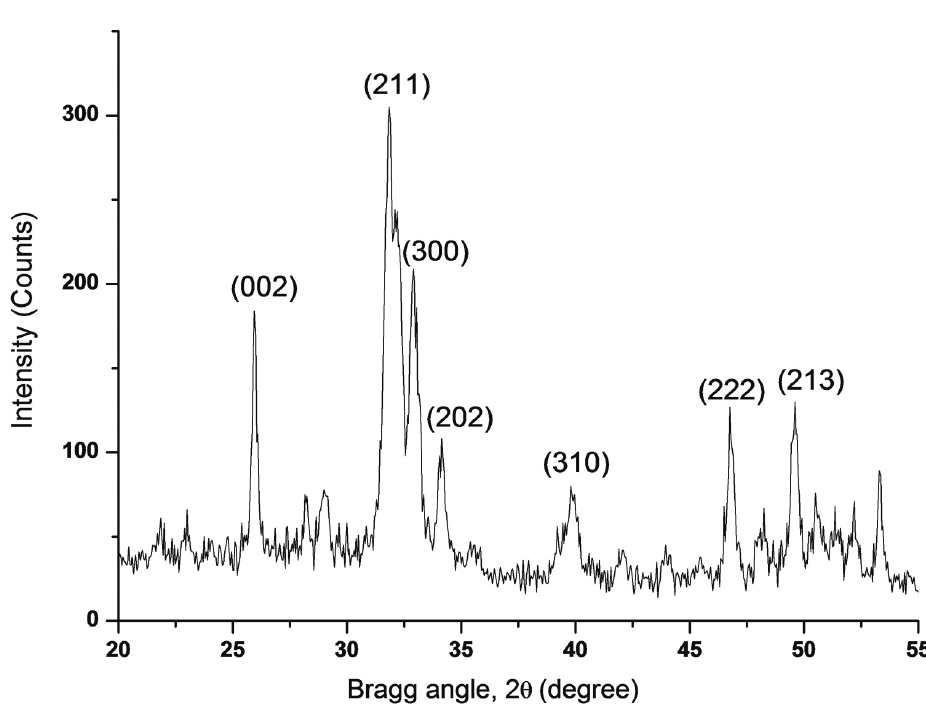
Figure 3. X-ray diffraction spectrum for synthetic